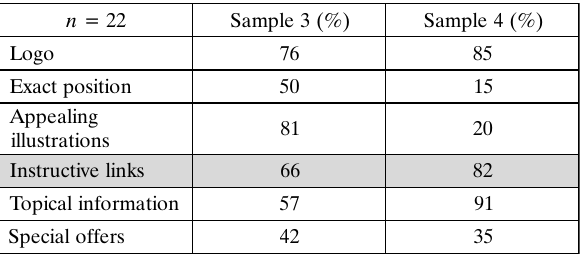
Table 5. Special features